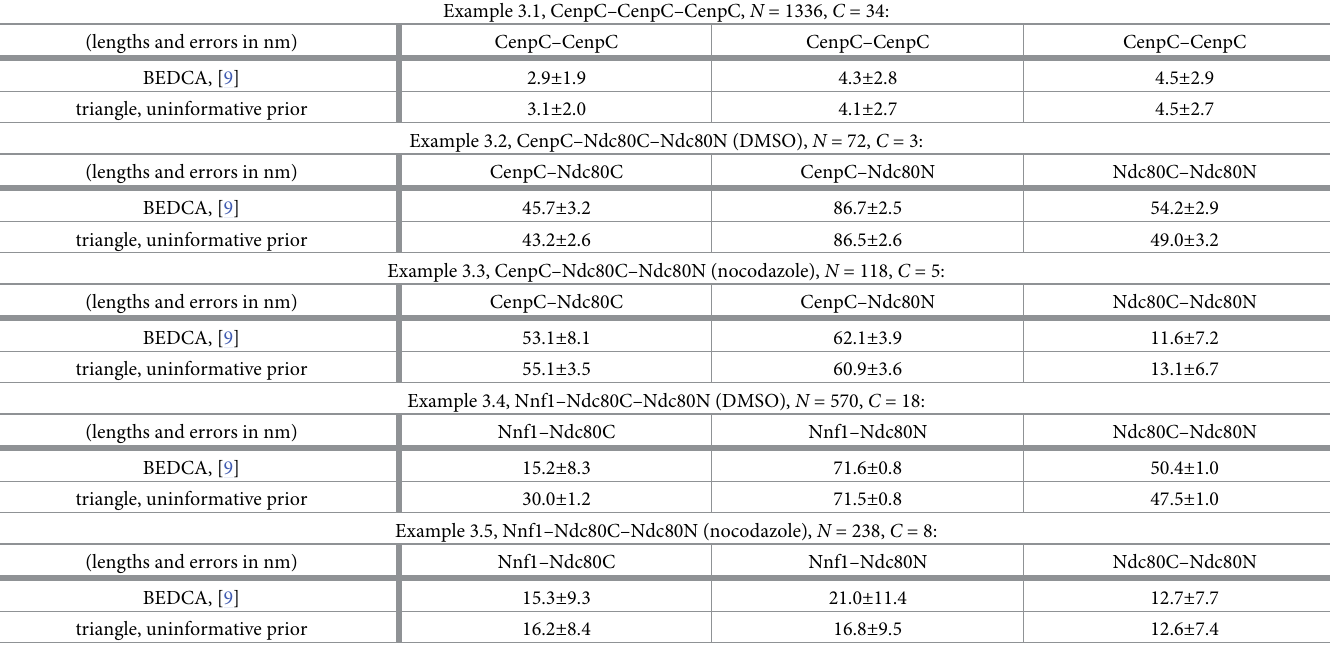
Table 3. Single-state analysis of experimental